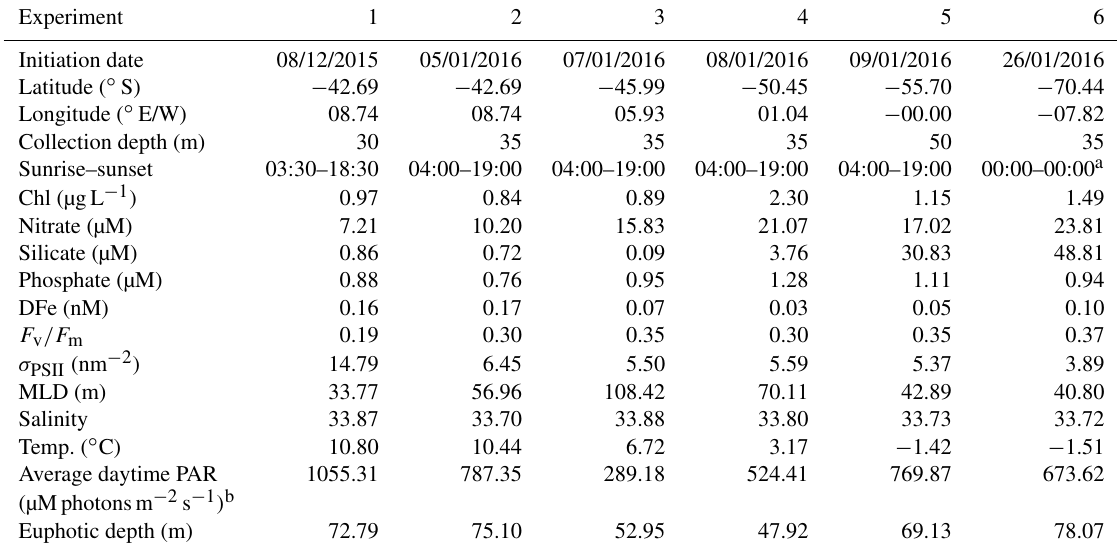
Table 1. Locations for PE experiments conducted during the cruise along with details for the initial chemical, physiological and physical setup